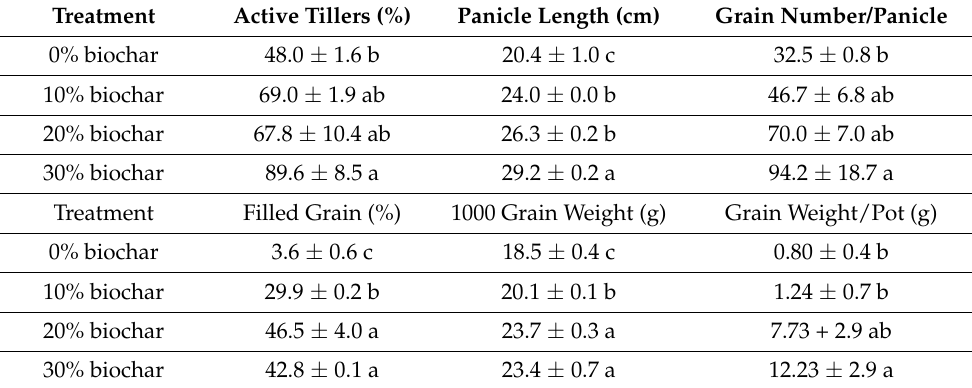
Table 1. Yield and yield components of Phitsanulok 2